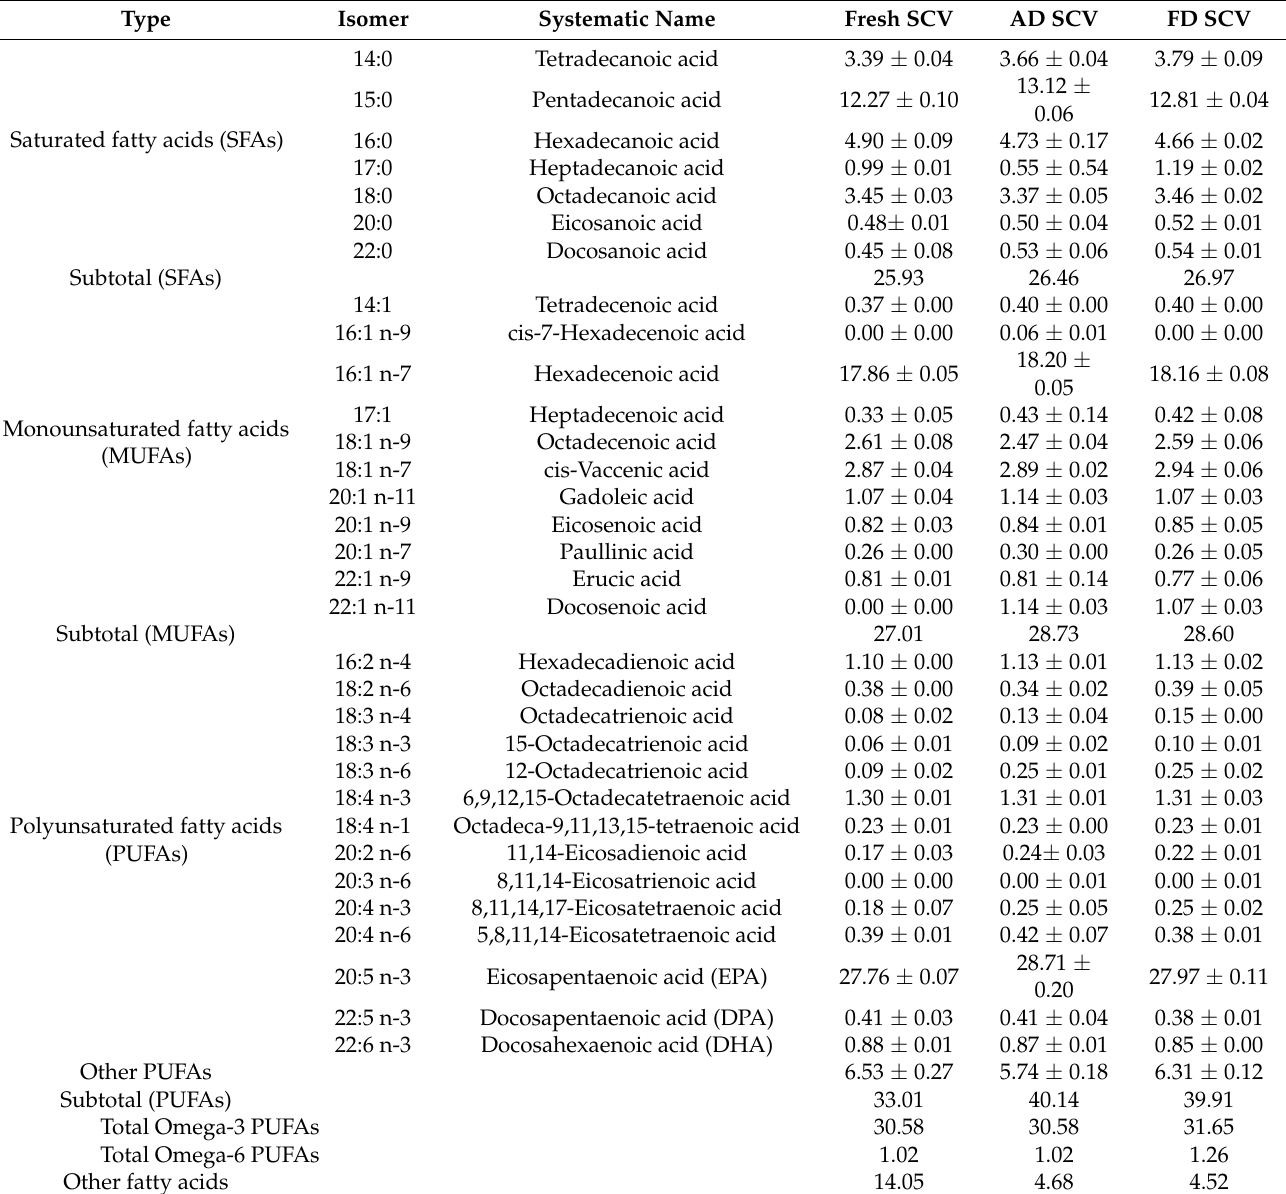
Table 3. Total fatty acid composition of fresh, air-dried (AD SCV), and freeze-dried (FD SCV) sea cucumber viscera.